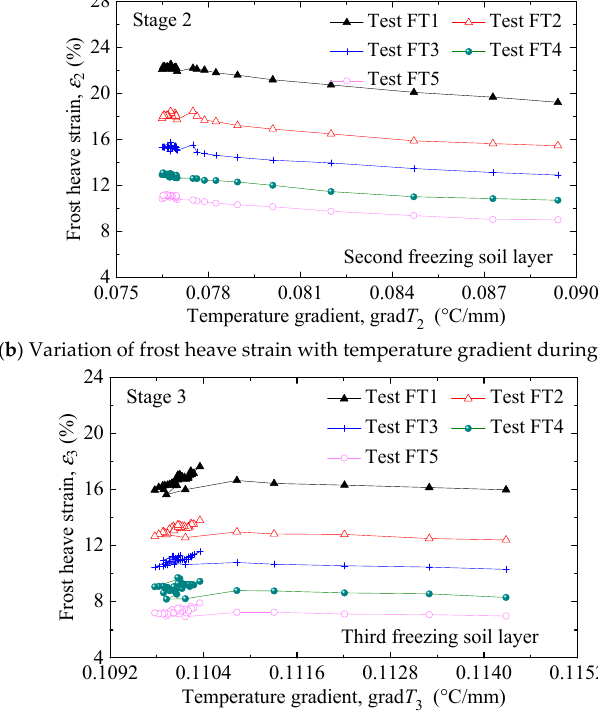
Figure 12. Relationship between frost heave strain and temperature gradient in the freezing soil layers during ( a ) stage 1, ( b ) stage 2, and ( c ) stage 3.